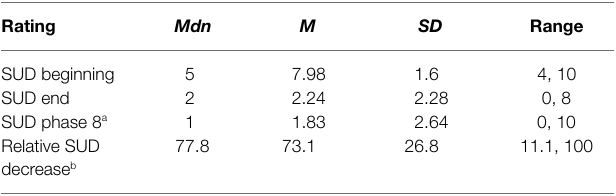
TABLE 3 | Descriptive statistics of different subjective unit of disturbance (SUD)